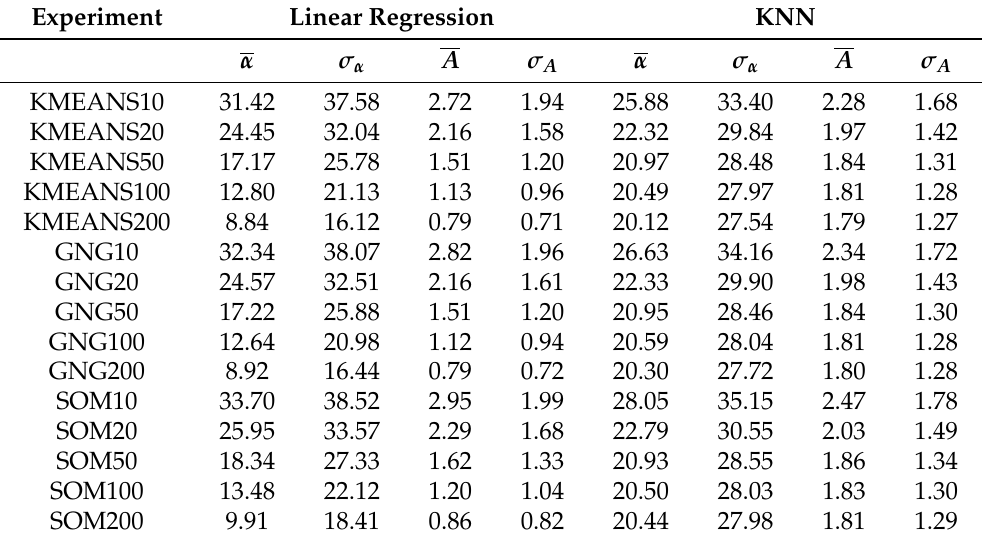
Table 1. Table showing the reconstruction error measured as the average angular and amplitude error ( α and A ) and its standard deviation ( σ α and σ A ) for linear regression and KNN for sensor location selection using the k-menas, GNG, and SOM algorithms with default algorithm settings. Amplitude is given in m/s, angle in degrees.